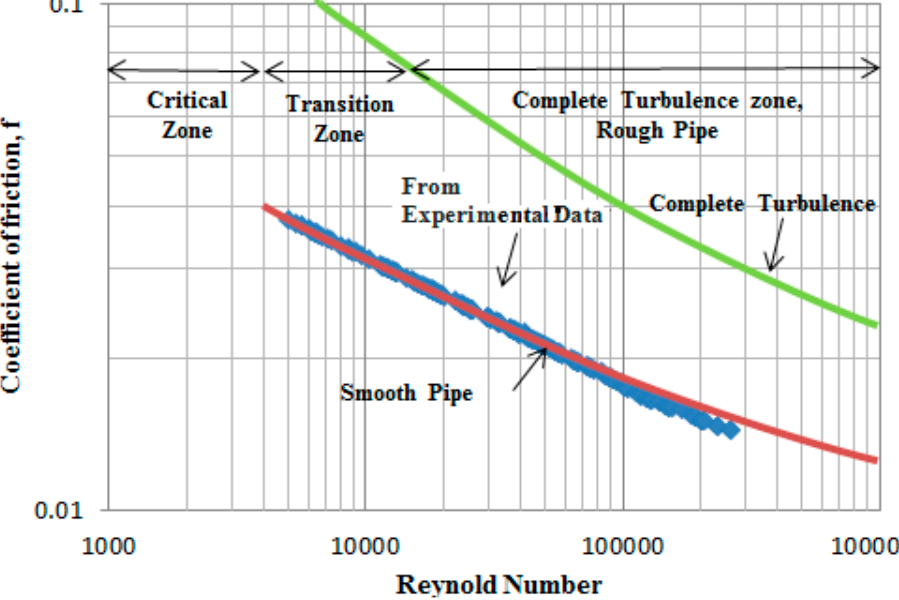
Figure 9. Variation of the coefficient of friction throughout the experiments.